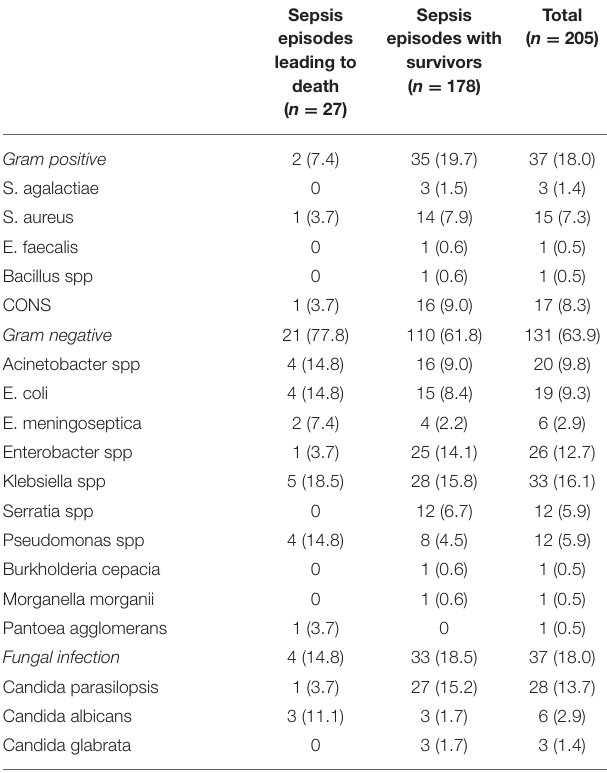
TABLE 2 | Distribution of microorganisms isolated in late onset sepsis episodes ( n =